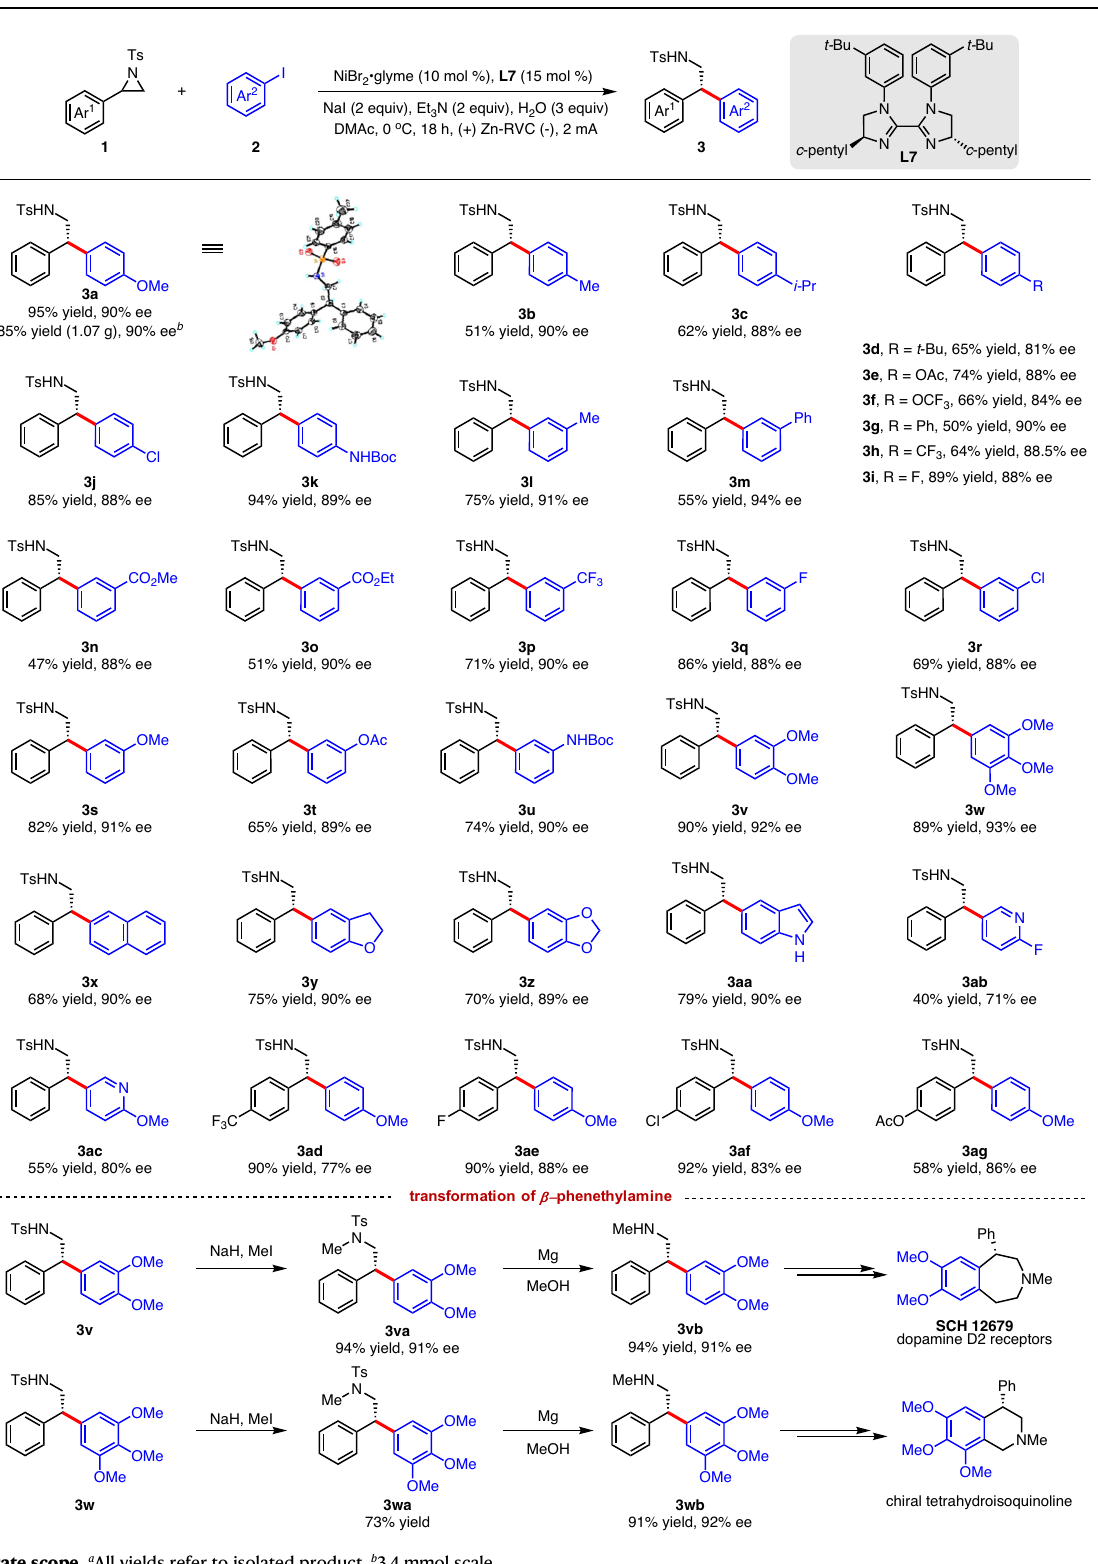
Fig. 3 | Substrate scope. a All yields refer to isolated product. b 3.4mmol